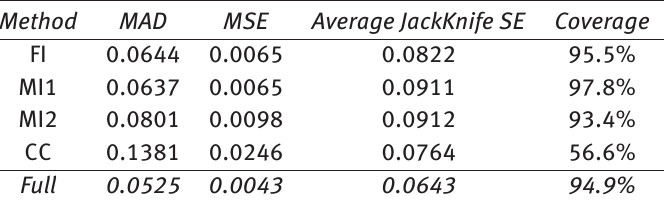
Table 2: Mean, Coverage, and Execution Results by Method: IPW